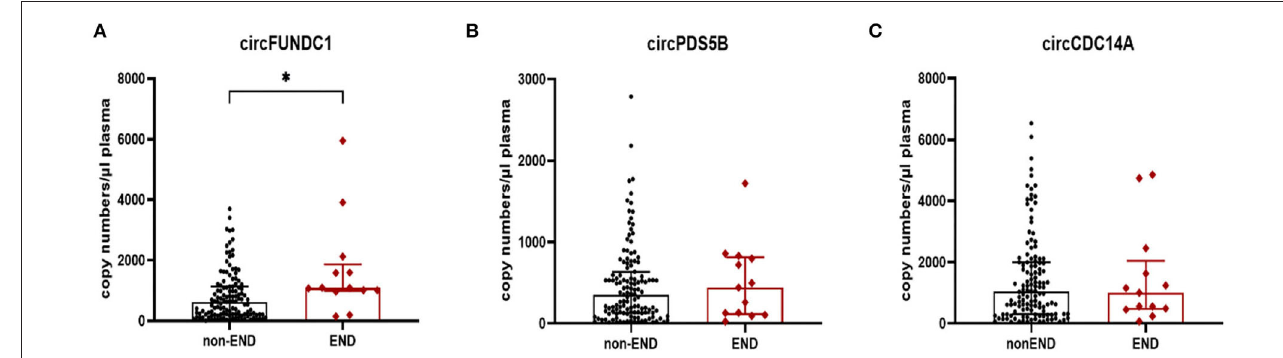
FIGURE 5 | Expression of circFUNDC1 (A) , cricPDS5B (B) , and circCDC14A (C) in acute ischemic stroke (AIS) patients. END, early neurological deterioration. Median ± interquartile range, Mann-Whitney test. * P < 0.05.